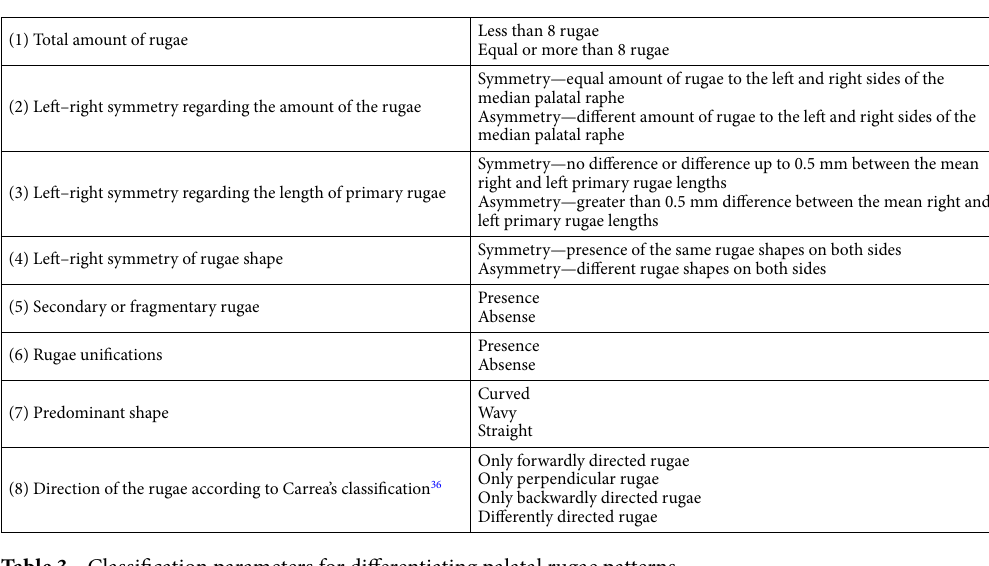
Table 3. Classification parameters for differentiating palatal rugae patterns.